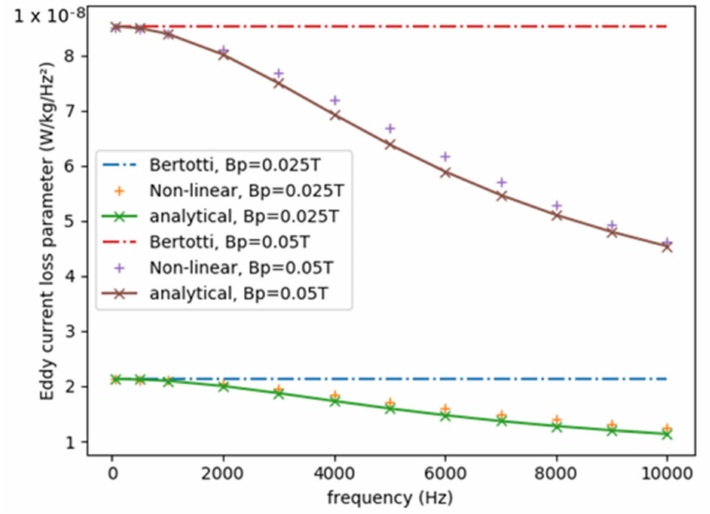
Figure 3. Comparison of eddy-current loss constant, calculated using three di ff erent methodologies, for two average sinusoidal waveforms of small